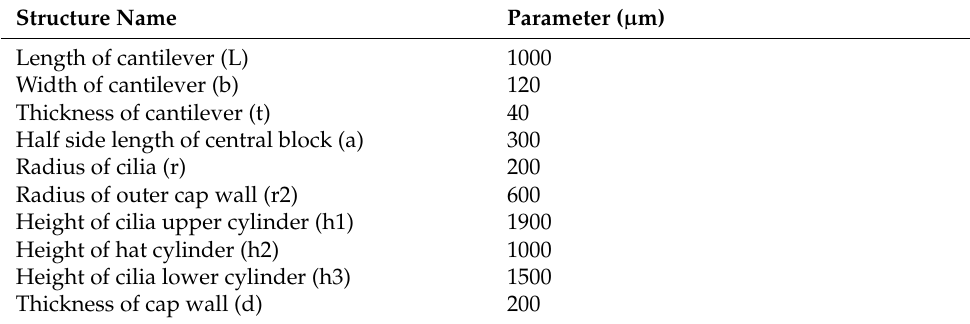
Figure 2. ( a ) Sensitive structure of sound pressure channel; ( b ) principle diagram of piezoelectric effect. Table 1. Parameters of sensitive structure.